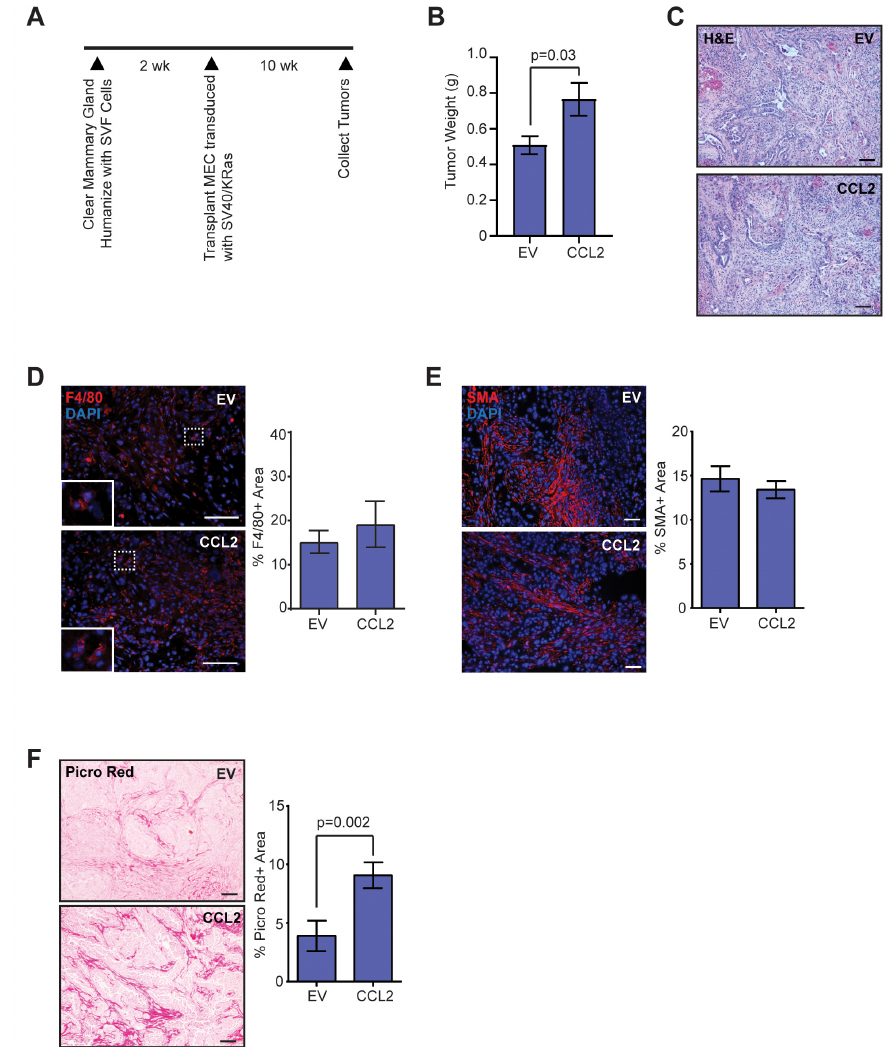
Figure 1. Elevated chemokine ligand 2 (CCL2) expression in stromal cells leads to increased